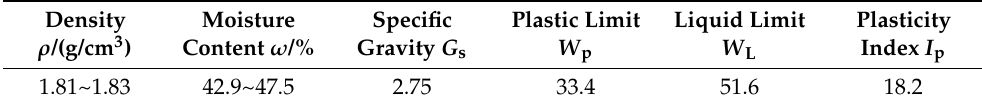
Figure 2. The QUANTA FEG 650 field emission scanning electron microscope. Table 1. Physical and mechanical parameters of the soil sample.